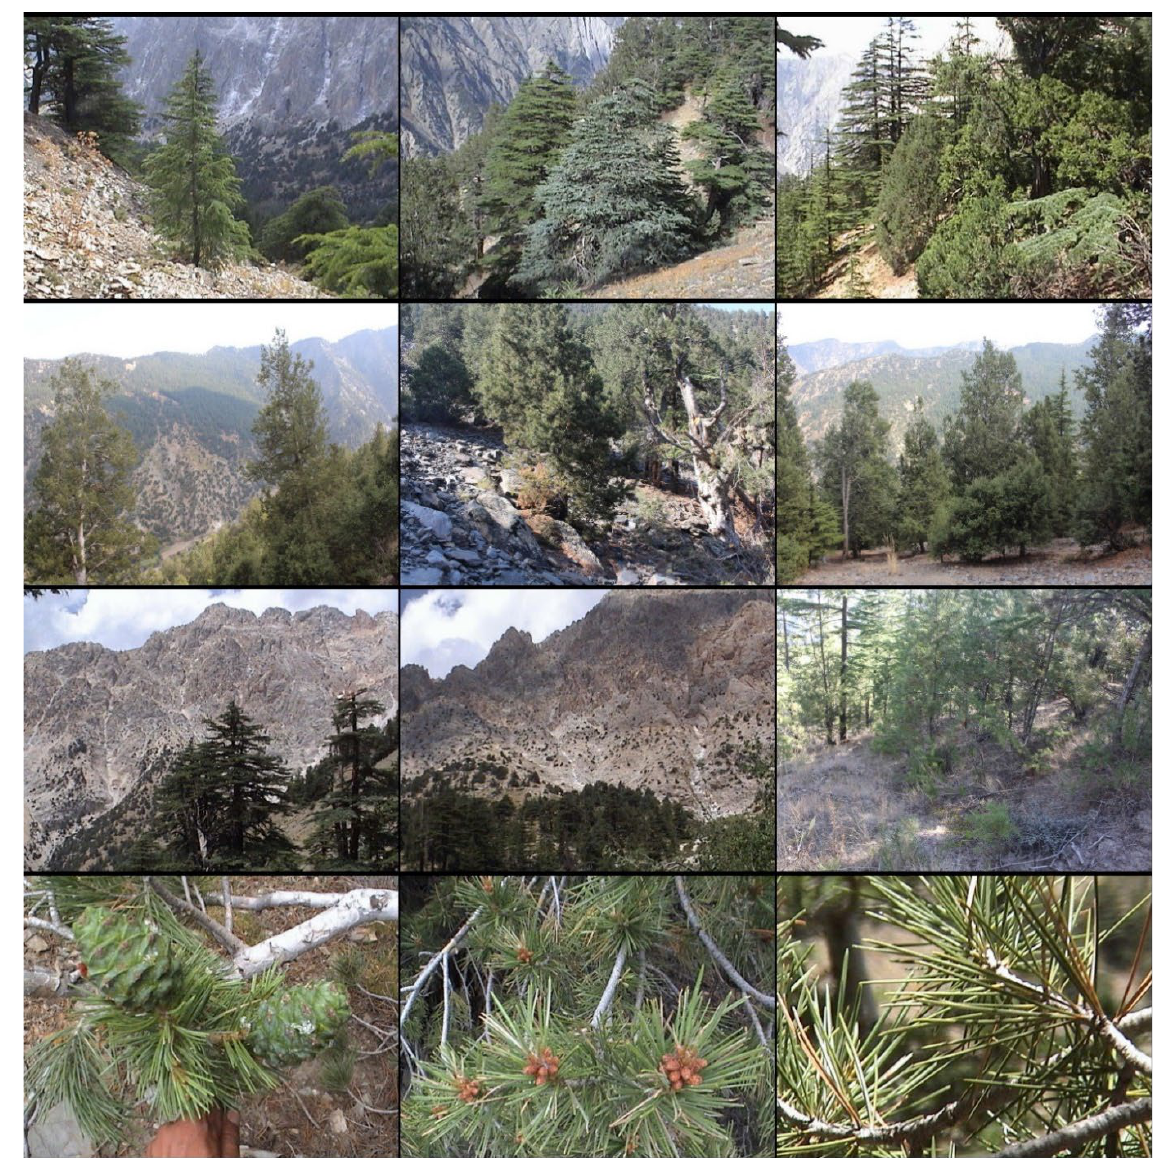
Figure 1. An assortment of images taken of dry temperate microhabitats supporting Pinus gerardiana populations in Koh-e-Sulaiman and Koh-e-Hindu Kush mountain ranges in Pakistan.